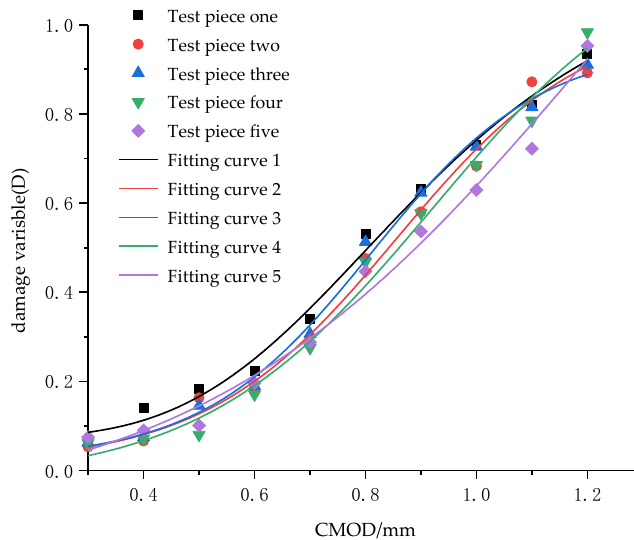
Figure 13. Relationship between CMOD and damage variables.